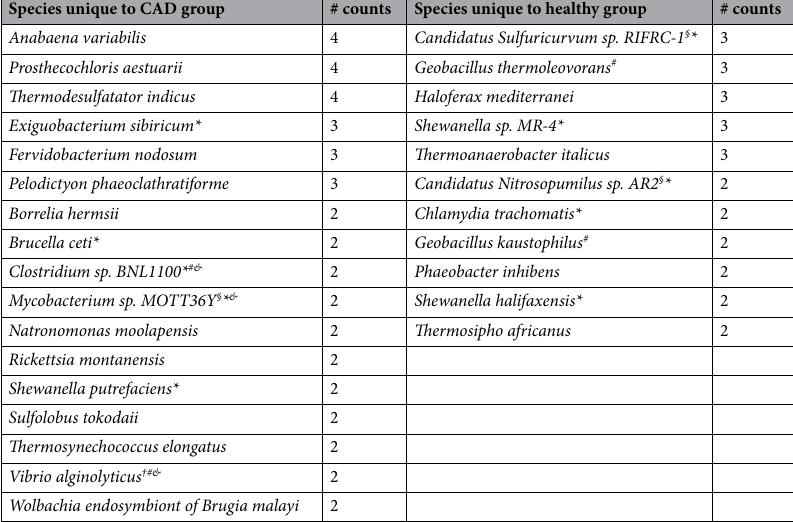
Table 1. Most frequent species unique to coronary artery disease (CAD) and healthy groups. A total of 51 species were found only in individuals with CAD and 41 were present only in healthy individuals. The complete list of microorganisms found only in the CAD group or the healthy group is available in Table S3. *Contaminant; # Hard palate; & Soft palate; % Tonsils; † Subgingival and supragingival plaques; § Subgingival plaqu; ¶ The Human Oral Microbiome.